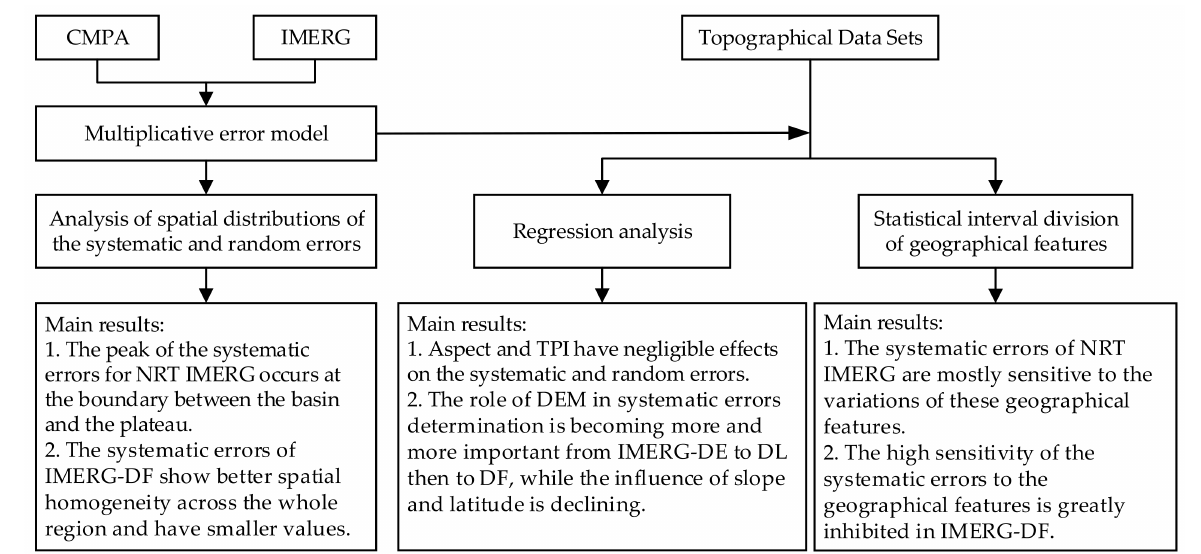
Figure 13. The flowchart of the analysis of the systematic